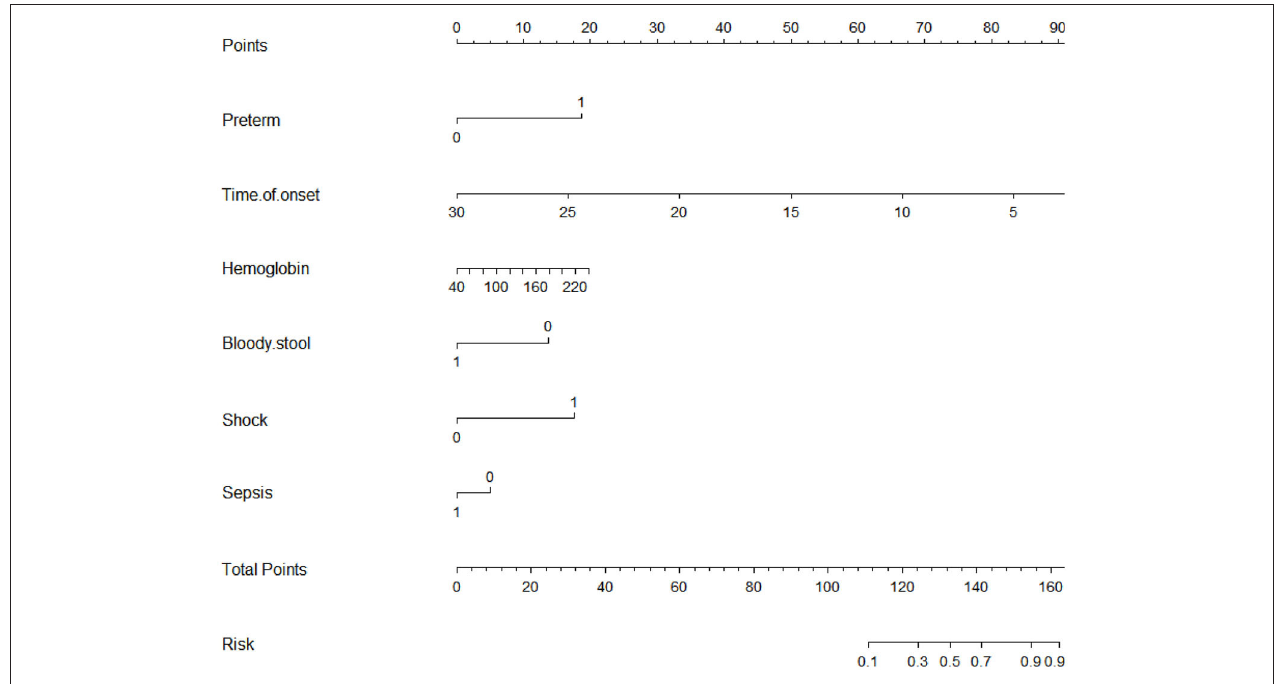
FIGURE 1 | Nomogram for prediction of gastrointestinal sites.